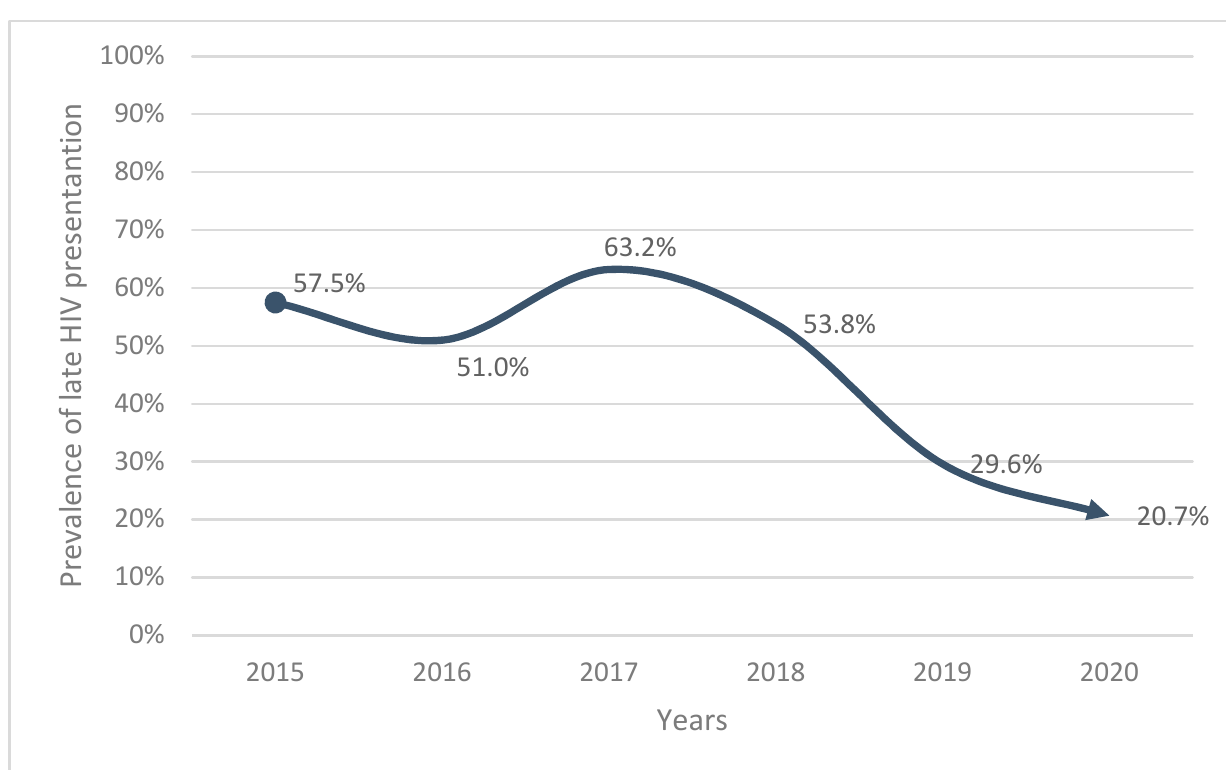
Figure 1. Prevalence of late HIV presentation over the years.